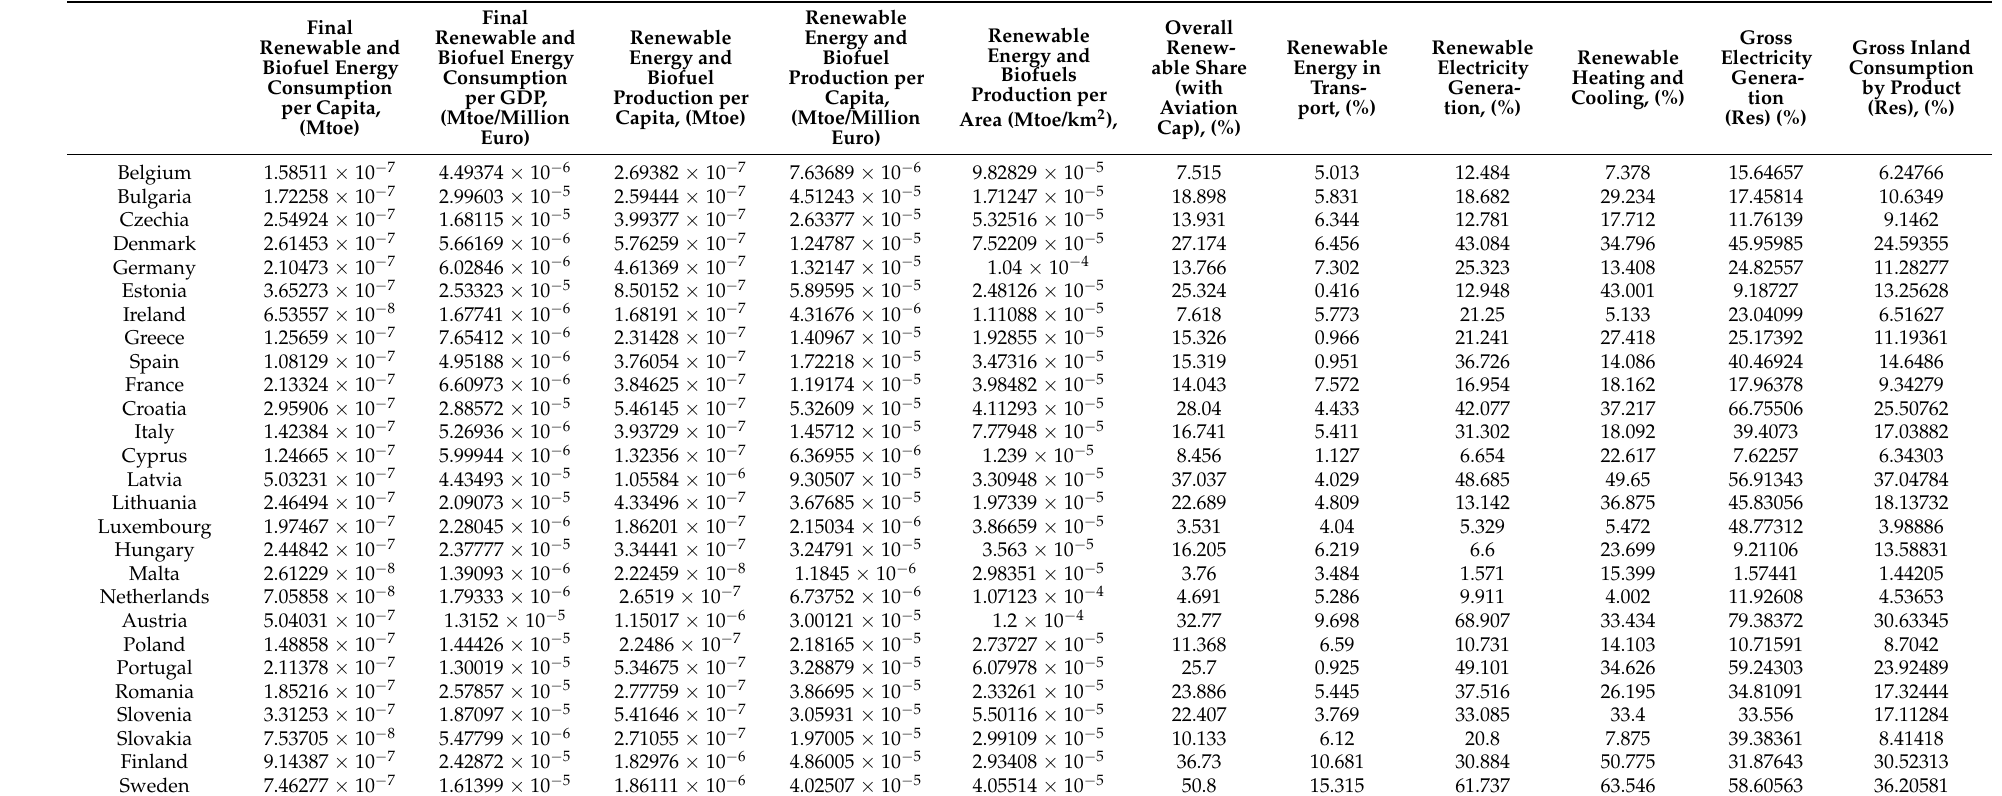
Table A2. Values Renewable energy indicators in 2013 (own elaboration based on